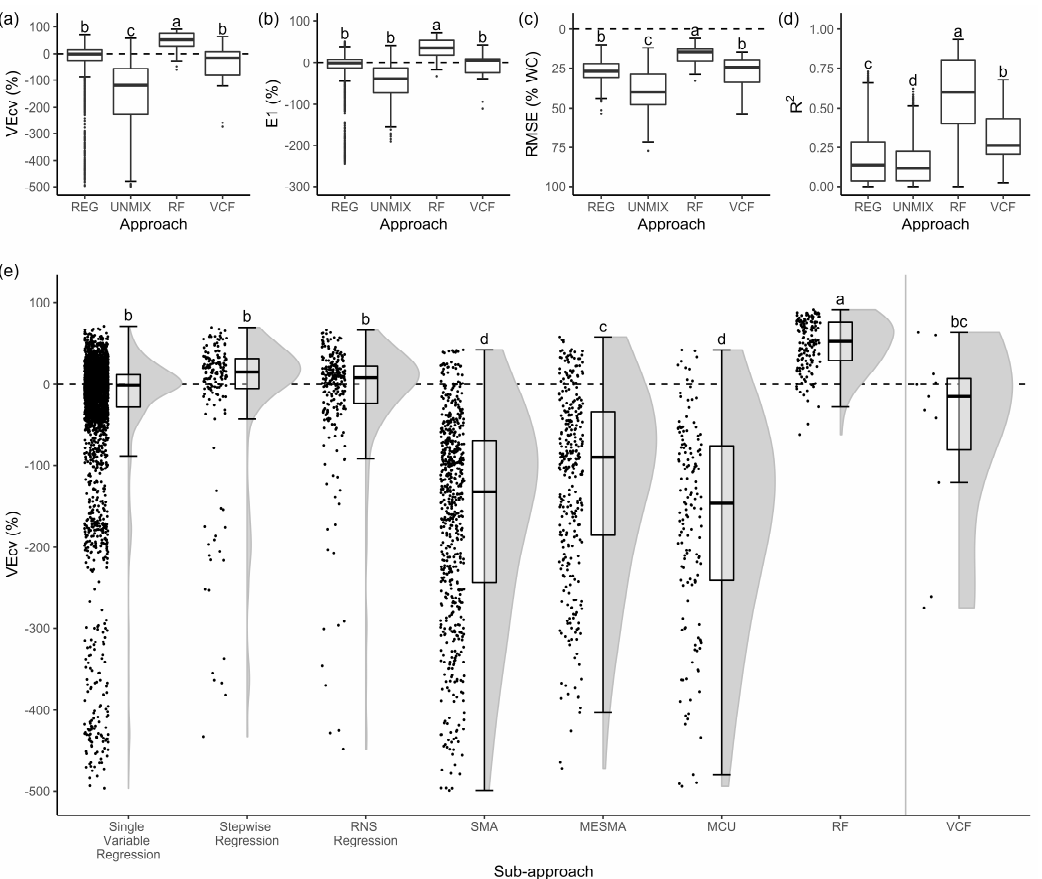
Figure 4. Approach and sub-approach accuracies. Across all accuracy measures, RF significantly outperformed the other approaches ( a - d ). However, we note that of the accuracy measures, R 2 was the only to give Vegetation Continuous Fields (VCF) a median score significantly higher than the regressions (REG), demonstrating the discrepancies created when using R 2 as a measure of accuracy. Among the sub-approaches ( e ), RF remained the best performer, significantly outperforming the others. In all plots, letters signify approaches whose accuracies were not significantly di ff erent (p < 0.05). We tested for significance using ANOVAs and post-hoc Tukey honest significant di ff erent tests. In the boxplots, the bold centerline represents the median score, the box encompasses the 2 nd and 3 rd quartiles, and the top and bottom whiskers respectively represent the largest and smallest values within 1.5 times the interquartile range. Values outside that range are marked as outliers. In the sub-approach plot ( e ), to the left of the boxplots, points representing the accuracies of individual maps are scattered horizontally to limit overlap. The points illustrate both the number and distribution of map scores. To the right of the boxplots, smoothed histograms further illustrate the distribution of each sub-approach’s scores. The gray line separates VCF from the other results as a reminder that this was not a true accuracy assessment of VCF (VCF does not incorporate all WC as our maps